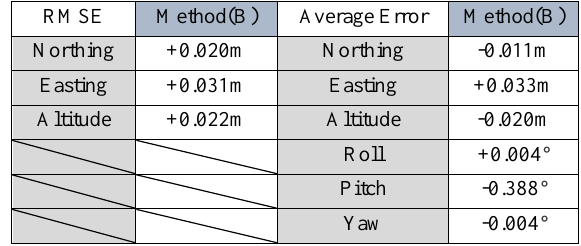
Table 3. RMSE of the check points and positional and orientational error of the images generated by Method(A).